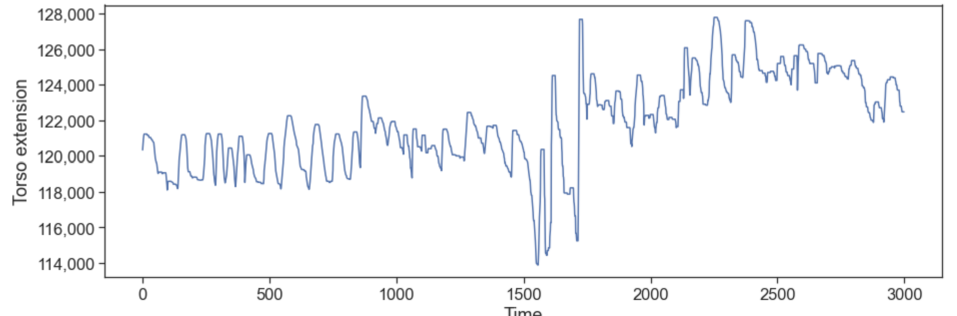
Figure 4. The moving maximum signal as generated from one participant, in the field study data, during the walking and sitting periods, including the talking and non-talking segments. The window size used for calculating M ( i ) is 12 in this case. Every time unit corresponds to approximately 0.08